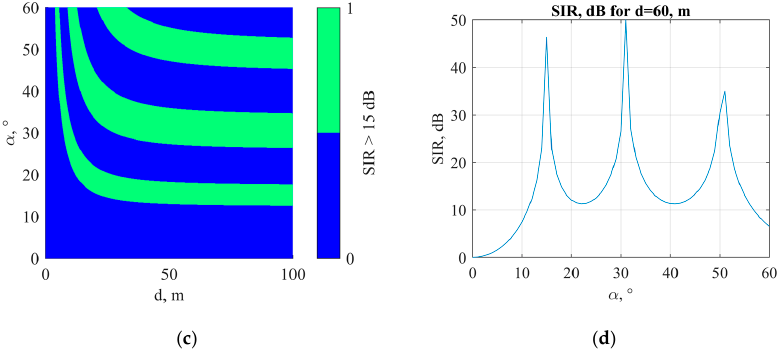
Figure 3. Simulation scenario 3: ( a ) gNB with two AA patterns and two UEs on the x-y plane; ( b ) Map of UE SIR values for a set of terrestrial and angular separation; ( c ) Map of SIR values exceeding a given threshold for a set of terrestrial and angular separation; ( d ) Map of SIR values for a set of angular separation and fixed terrestrial separation.